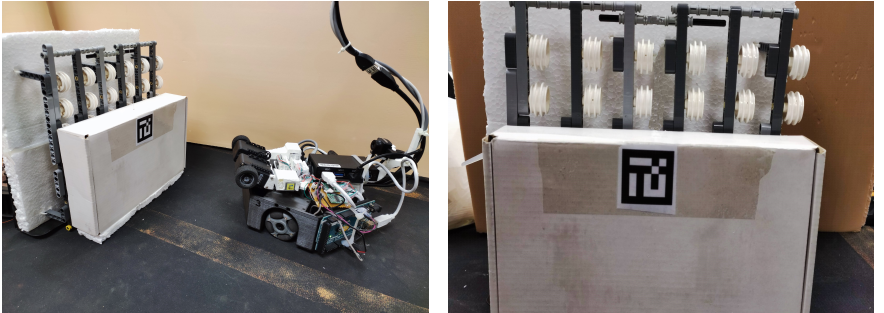
Figure 5. Setup and target